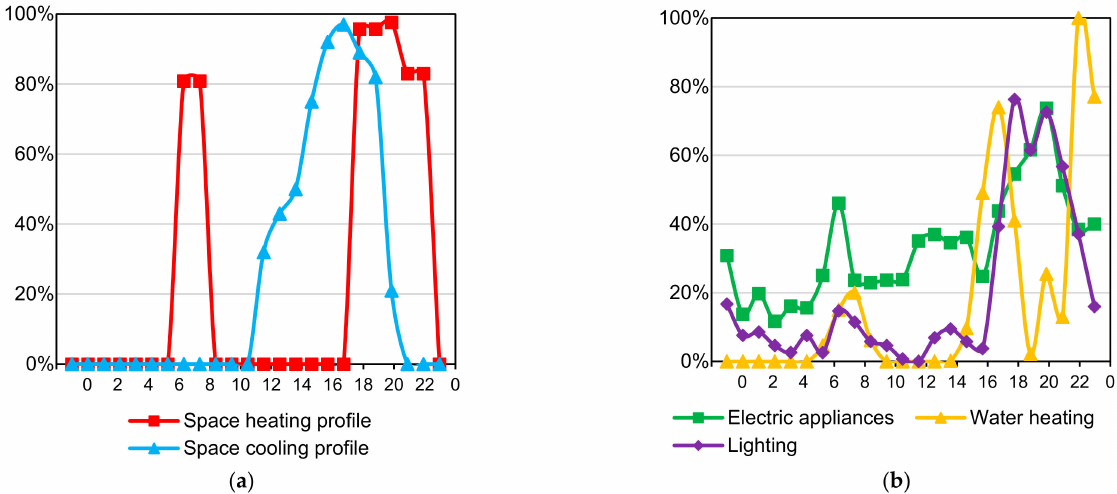
Figure 3. ( a ) Typical load profiles of space heating and cooling; ( b ) typical load profiles of electric appliances, water heating and lighting. Case-study house located in Central Italy [132]. Percentages of the peak average daily load.